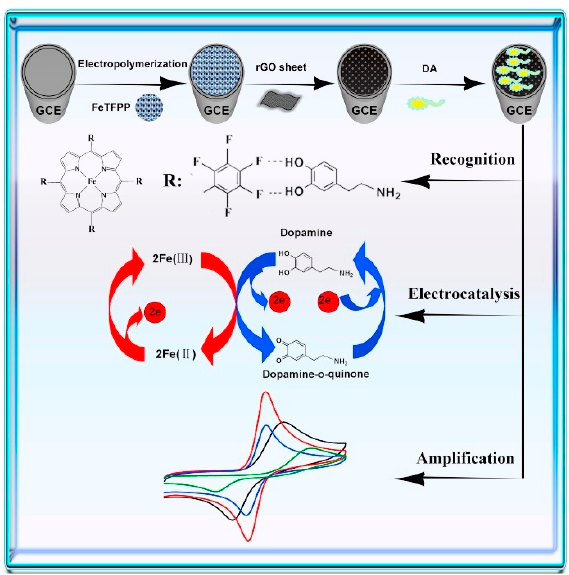
Figure 2. Scheme fabrication process of the biomimetic sensor and the catalytic process for the oxidation of dopamine. Reprinted from [71] with permission of Elsevier.